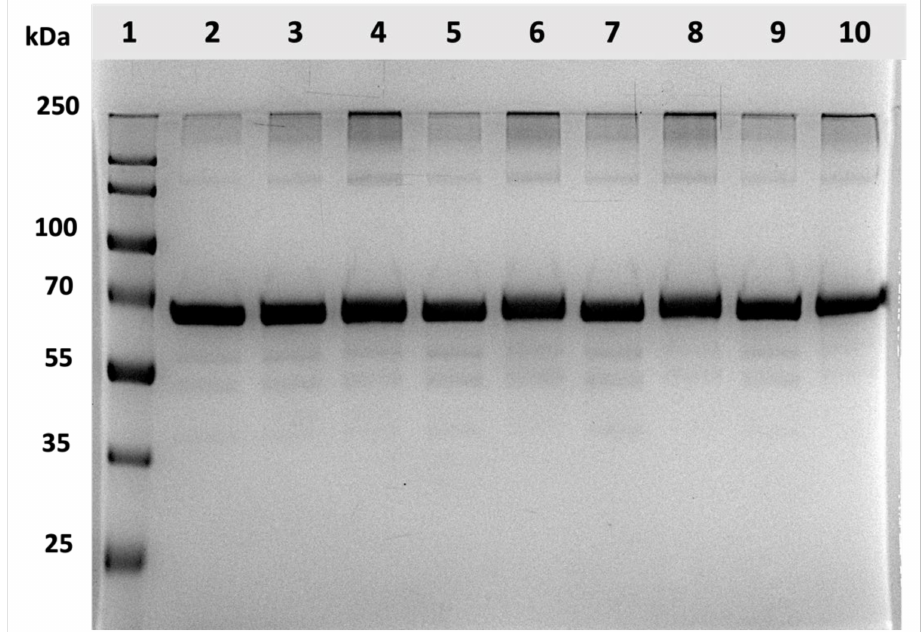
Figure 7. SDS-PAGE gel images of the lyophilized CUR-BSA nanoplexes before and after 30-day exposures at 40 ◦ C and 75% RH. Column 1 is the protein ladder; Column 2 is the raw BSA; Columns 3, 5, 7, and 9 are pre-exposure lyophilized nanoplexes prepared at 0, 33.33%, 50.00%, and 66.66% sucrose mass fractions, respectively; Columns 4, 6, 8, 10 are postexposure lyophilized nanoplexes prepared at 0, 33.33%, 50.00%, and 66.66% sucrose mass fractions,